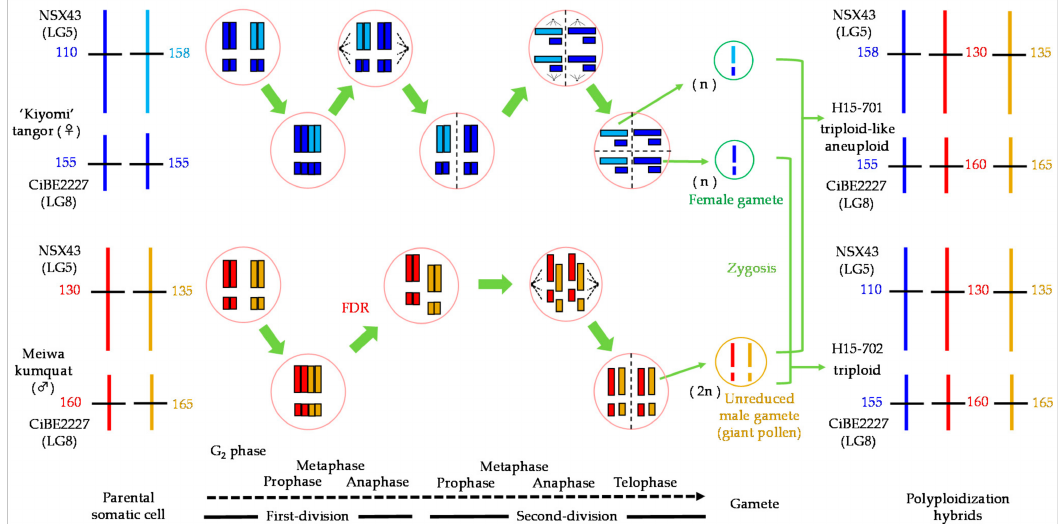
Figure 5. Identification of parental genome construction and unreduced gametes in the intergeneric hybrids between ‘Kiyomi’ tangor and Meiwa kumquat based on SSR genotyping in NSX43 (LG5) and CiBE2227 (LG8) loci.